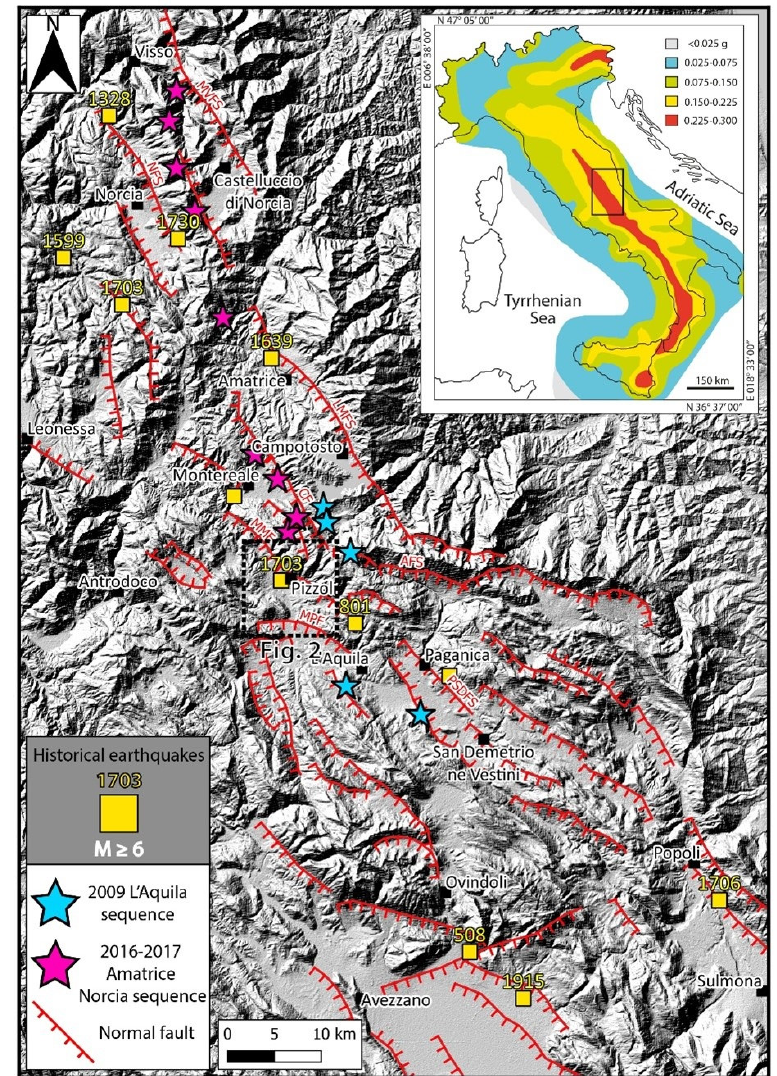
Figure 1. Map of the M ≥ 5 mainshocks of the 2016–2017 Central Italy (magenta stars) and 2009 L’Aquila (light blue stars) seismic sequences. The upper-right inset shows the Italian seismic hazard map, with peak ground accelerations (g) with a 10% chance of being exceeded in 50 years [44]. Date and location of the macroseismic epicenters of the moderate-large historical earthquakes [45] are reported with the yellow squares. The major active normal faults in the area (modified after [35,42,46] are traced with red lines). MVFS = Mt. Vettore fault system; NFS = Norcia fault system; LMFS = Laga Mts. fault system; CF = Capitignano fault; MMF = Mt. Marine fault; MPF = Mt. Pettino fault; AFS = Assergi fault system; PSDFS = Paganica-San Demetrio fault system.